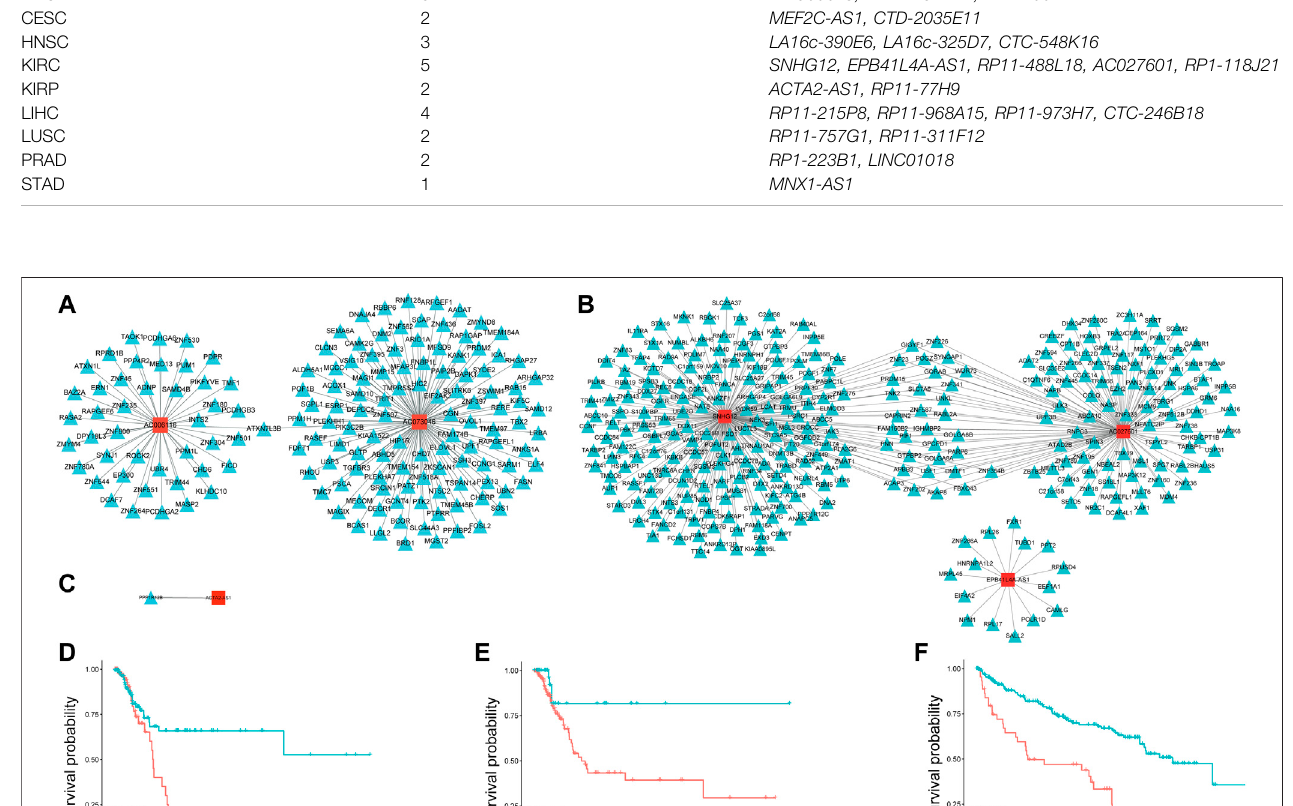
speci fi cally diagnostic markers for corresponding cancers. They not only exhibited synergistic alterations in expression and methylation, but were also closely associated with the survival of cancer patients.